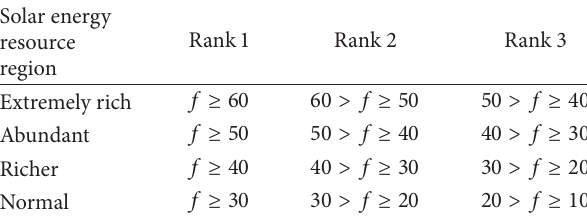
Table 7: Rank of the solar energy fraction for a solar air- conditioning system in different solar energy resource